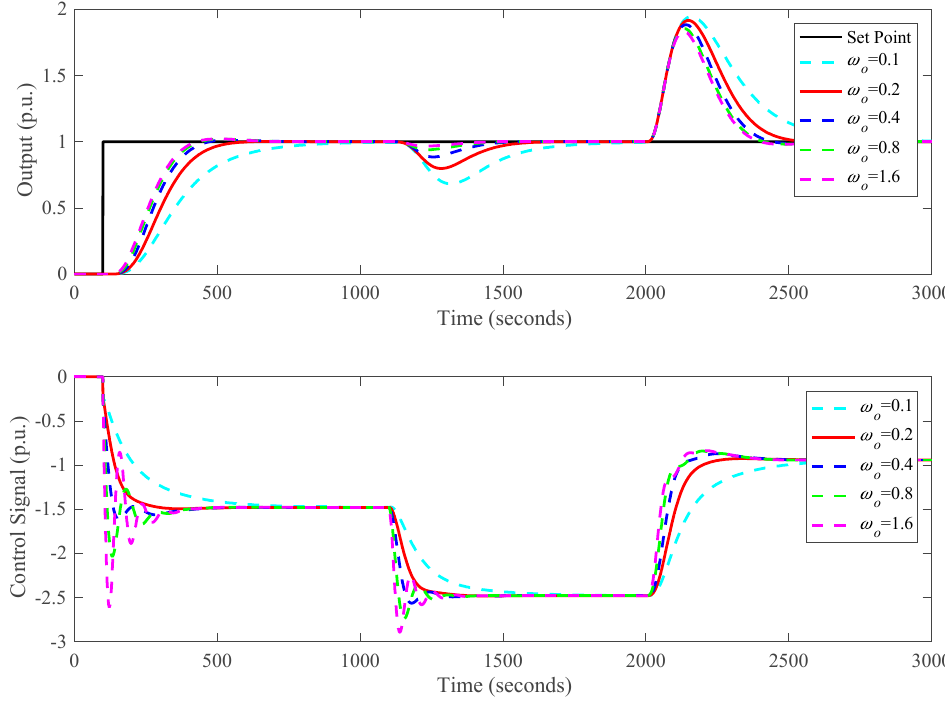
Figure 10. The influences on control performance with different ω o .